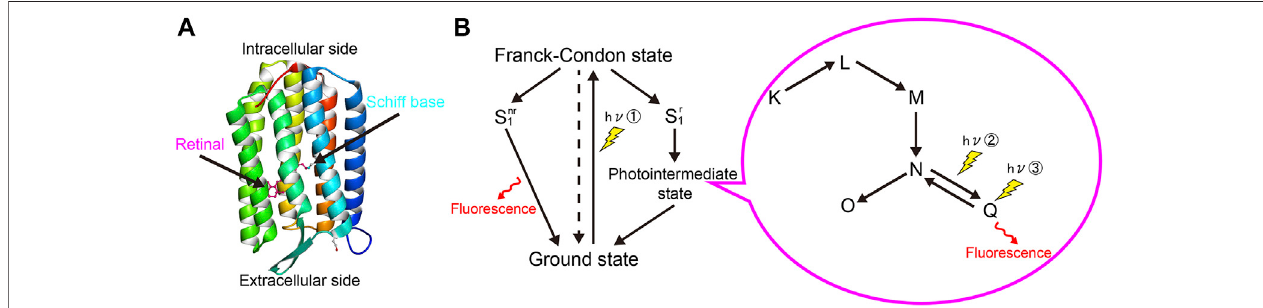
FIGURE1| Fluorescencemechanismofmicrobialrhodopsins. (A) CrystalstructureofArch(PDBcode:6GUZ).Rhodopsinisamembraneproteinwithaseven-fold transmembranealpha-helixstructureandconsistsofaproteinmoietycalledopsinandaretinalchromophorethatiscovalentlyboundtotheapoproteinviaaSchiffbase. (B) Photoreaction scheme of microbial rhodopsins. The spontaneous emission (left) occurs from the nonreactive S 1 state. The photointermediate fl uorescence (right) is from the Q-intermediate state produced by a photon absorption of the N-intermediate in its photocycle. Photointermediate fl uorescence arises through the sequential action of three photons ( ① - ③ ). The dashed line represents the non-radiative relaxation process.